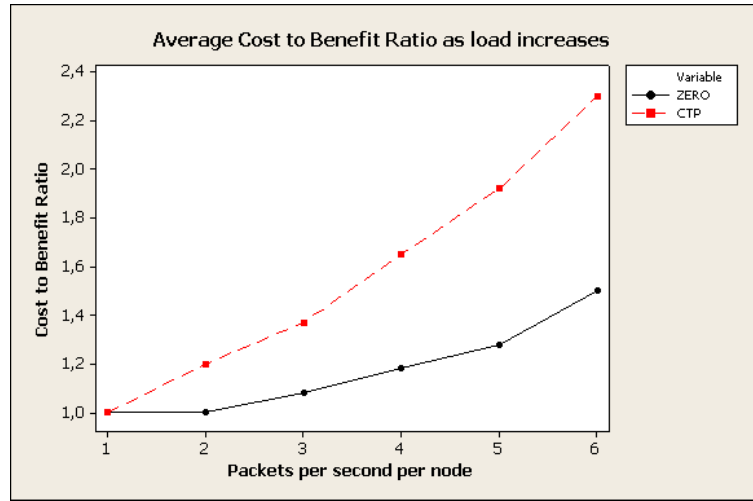
Figure 8. Cost benefit ratio for different loads of the